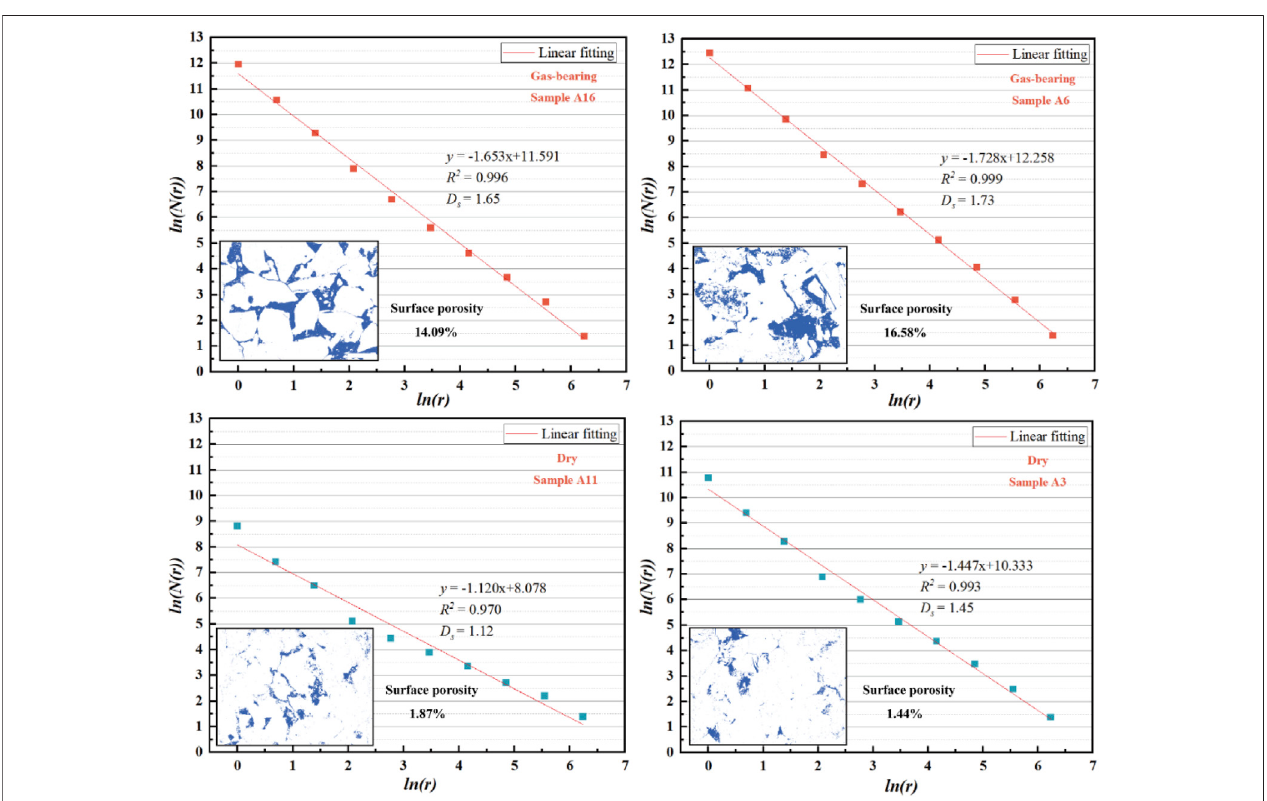
FIGURE7| Two-dimensionalfractalanalysisonthin-sectionimagesoftypicalgas-bearing(A16,A6)anddrysamples(A11,A3).*Ds:2Dfractaldimensionobtained from casting thin section image fractal analysis.